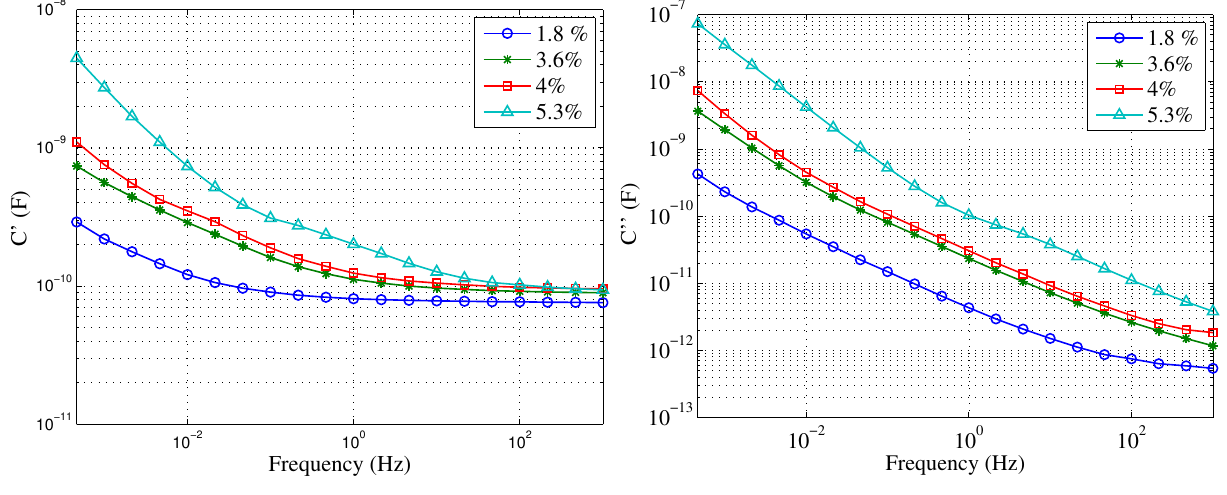
Figure 5. C’ and C” measured with Mesh B over samples with different moisture